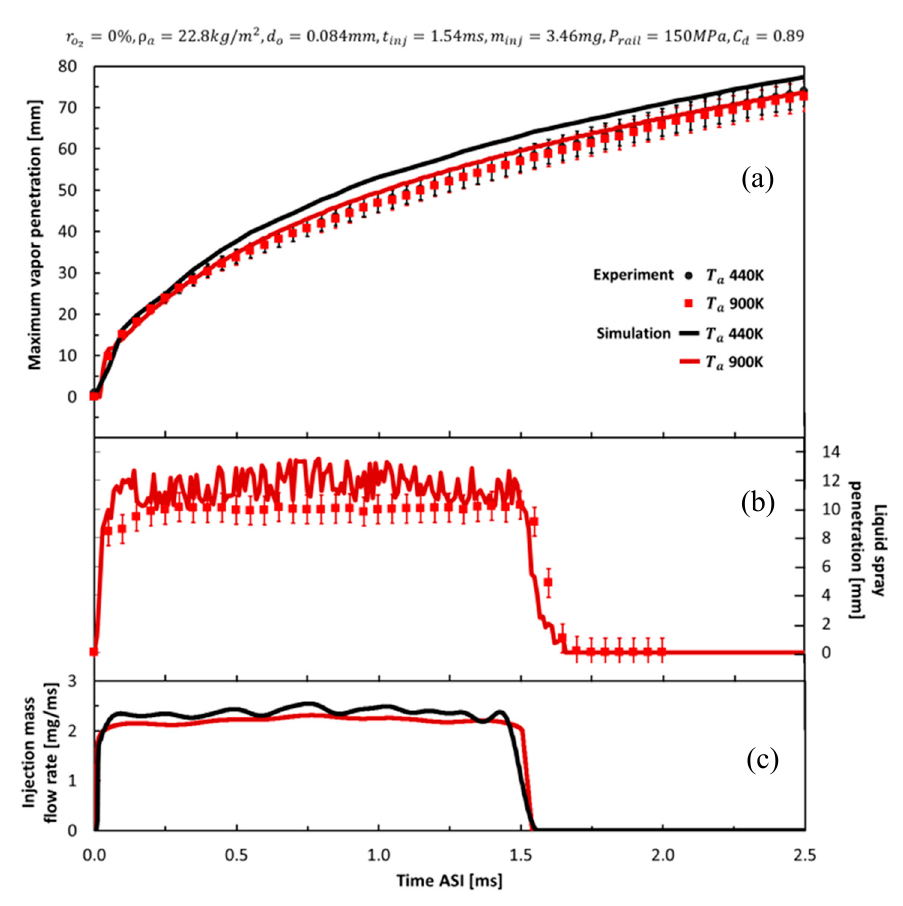
Figure 4. Comparison of the spray penetration of the experimental result [23] and simulation result at different ambient temperatures. ( a ) Maximum vapor penetration, ( b ) liquid spray penetration and ( c ) injection mass flow rate.